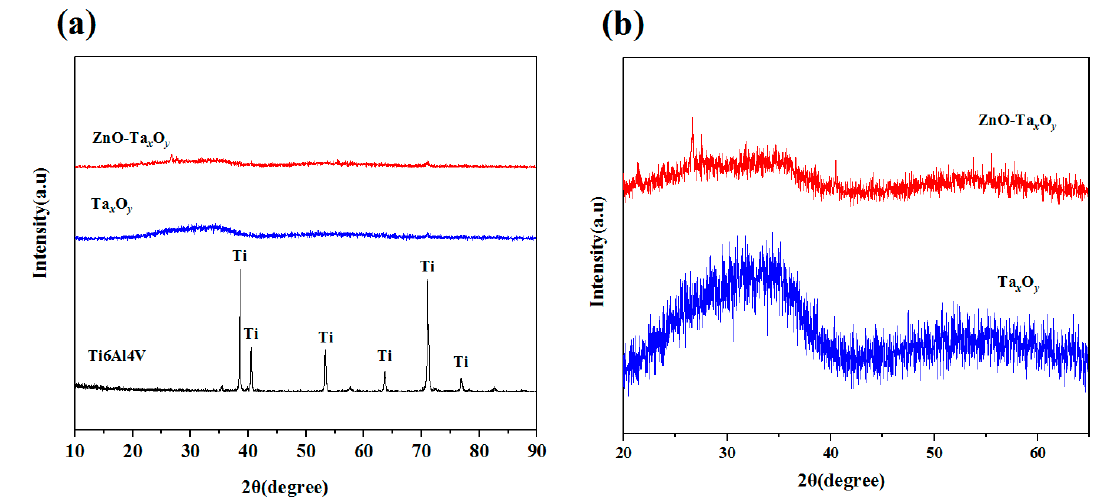
Figure 3. The cross-sectional SEM of coated Ti6Al4V samples of (a) Ta x O y and (b) ZnO-Ta x O y .